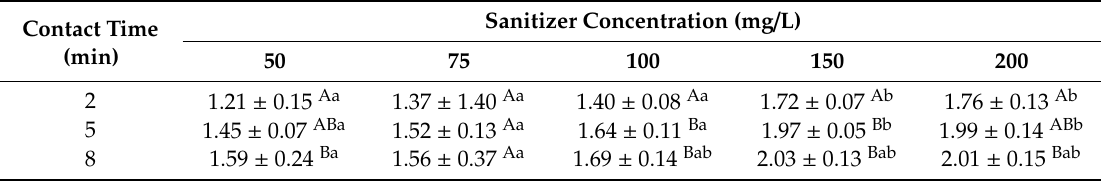
Table 2. Microbial count reduction (log CFU / g) of Escherichia coli O157:H7 after washing with di ff erent concentrations of polyhexamethylene guanidine hydrochloride (PHMG).